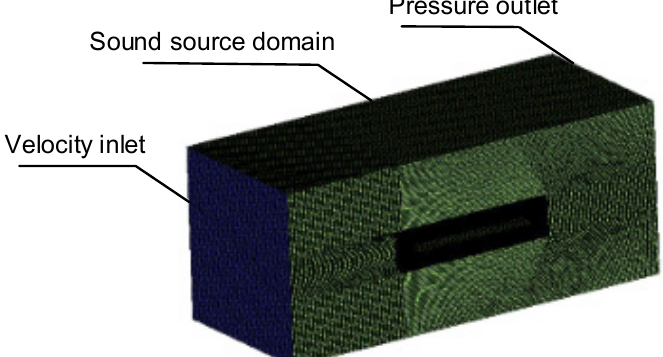
Figure 9. Flow field calculation model of plate wake.